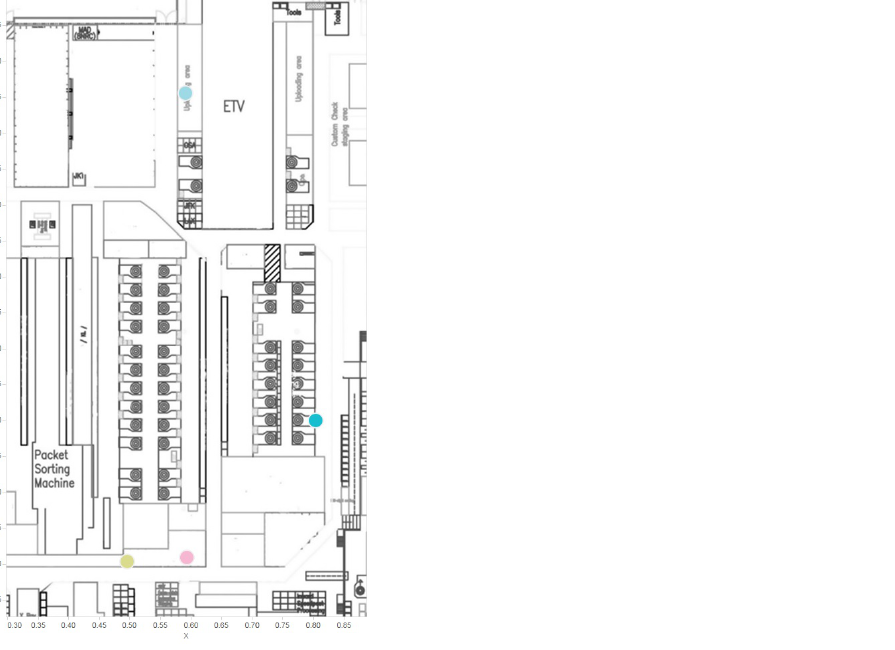
Figure 7. Real-time visualization of cart locations. The different colors represent different